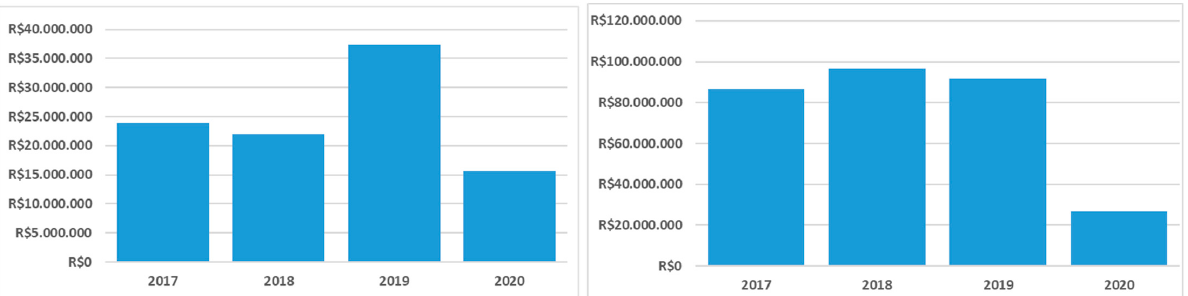
Figure 1. Budget of ICMBio and IBAMA for monitoring federal environmental protected areas—Paid budget from the 214P operation from ICMBio 214P-Environmental Inspection and protection of federal conservation units and Paid budget from the 214N operation from IBAMA 214N-Environmental control and inspection. Source: Artigo 19/ISA, s/d, using data from the “Portal do Orçamento”. Updated data from 2020, considering the present net values of 2017 and 2020.